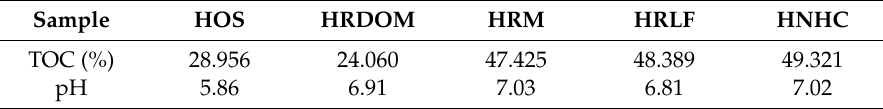
Table 1. TOC and pH of different fractions.